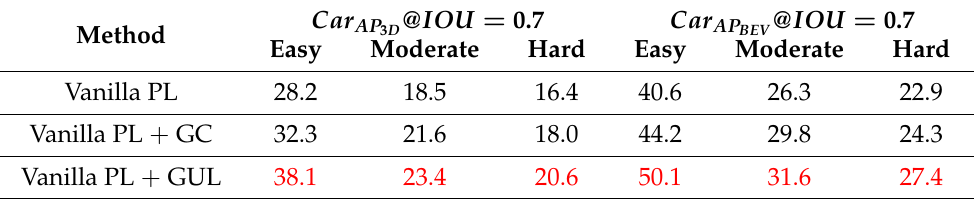
Table 6. Ablation study on input data with the “car” category of the KITTI validation subset. Method